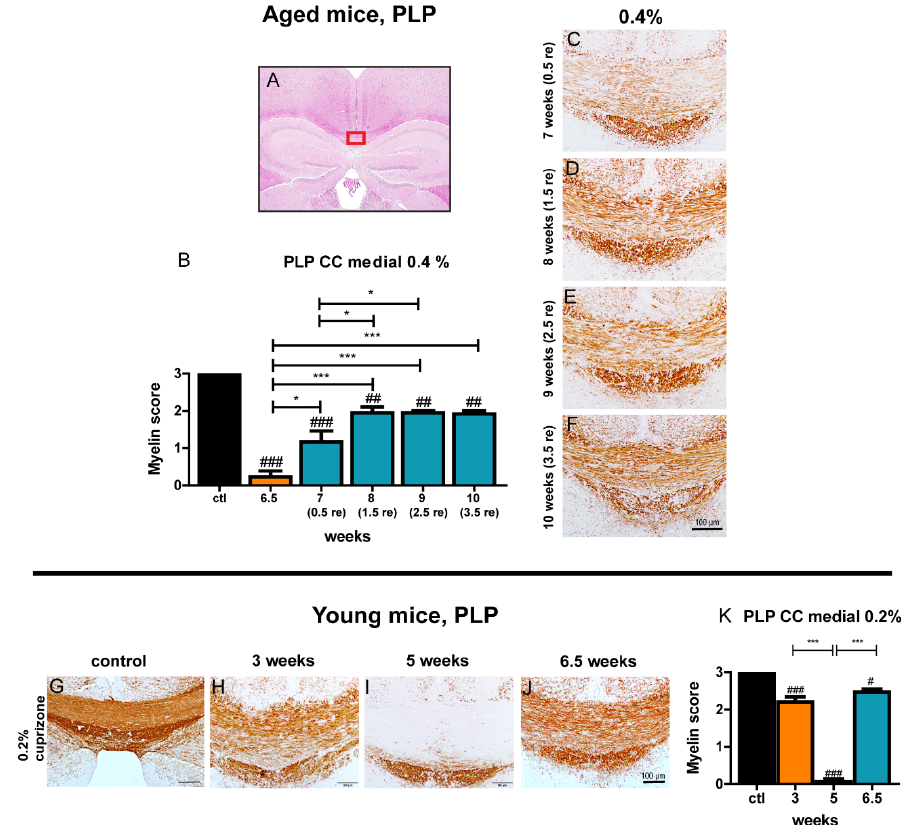
Figure 5. The marked area (red box) shows the medial part of the corpus callosum which was examined ( A ). ( B ) shows the myelin score for PLP in the midline of the corpus callosum in aged animals fed with 0.4% cuprizone for 6.5 weeks and subsequent remyelination (0.5, 1.5, 2.5, and